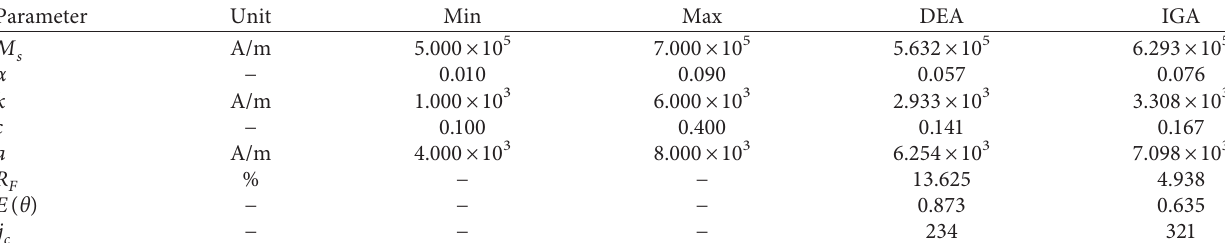
Table 2: First identification